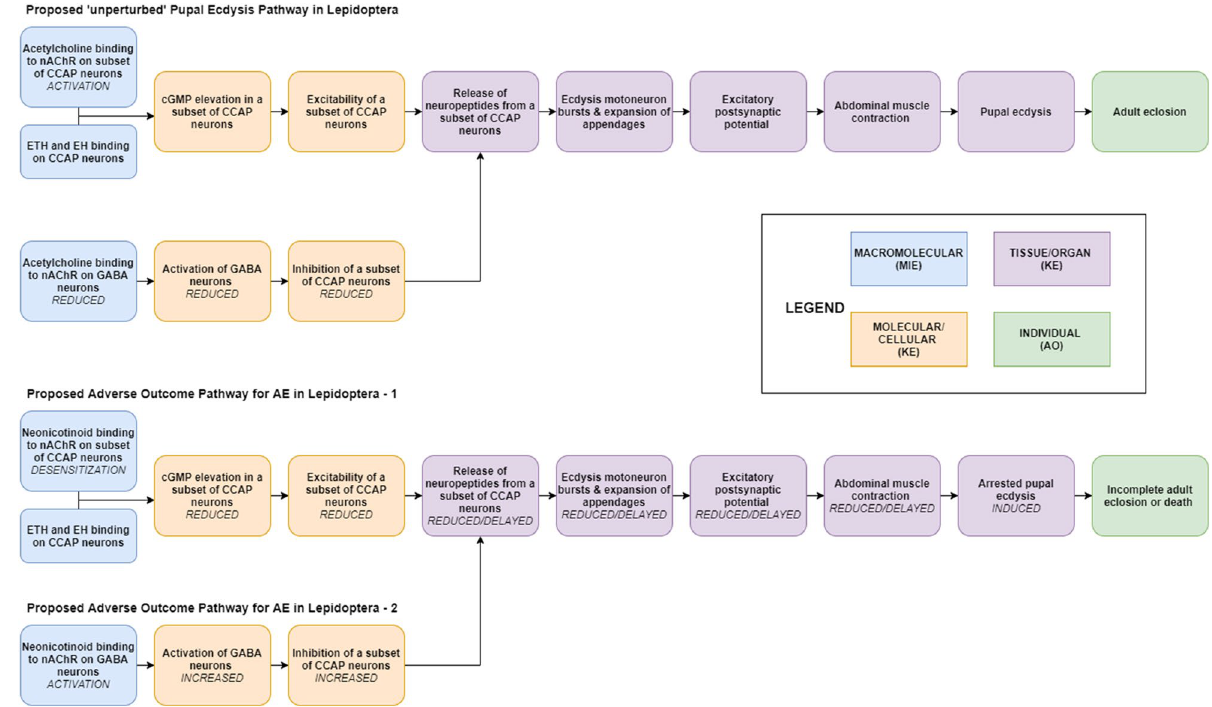
Figure 7. Proposed adverse outcome pathways that elucidate how neonicotinoid treatment could lead to arrested pupal ecdysis (AE). MIE molecular initiating event, KE key event, AO adverse